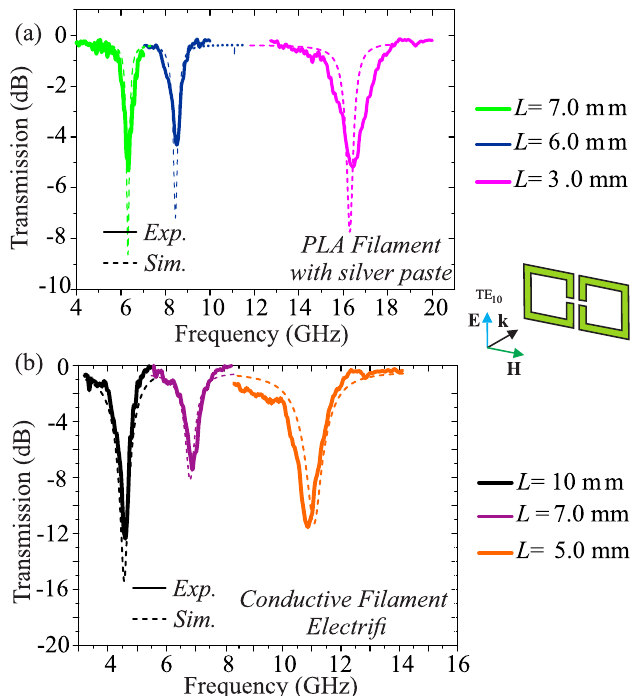
Figure 3. Electromagnetic investigation of the ( a ) PLA/Ag epoxy and ( b ) Electrifi built SRRs structure, experimental (solid curves) and numerical (dashed curves) transmission spectra. Cases of structures with variable length, L = 3–10 mm are presented. For all cases, the geometrical parameters are w = 1 mm, t = 0.4 mm and d = 0.6 mm as shown in Figure